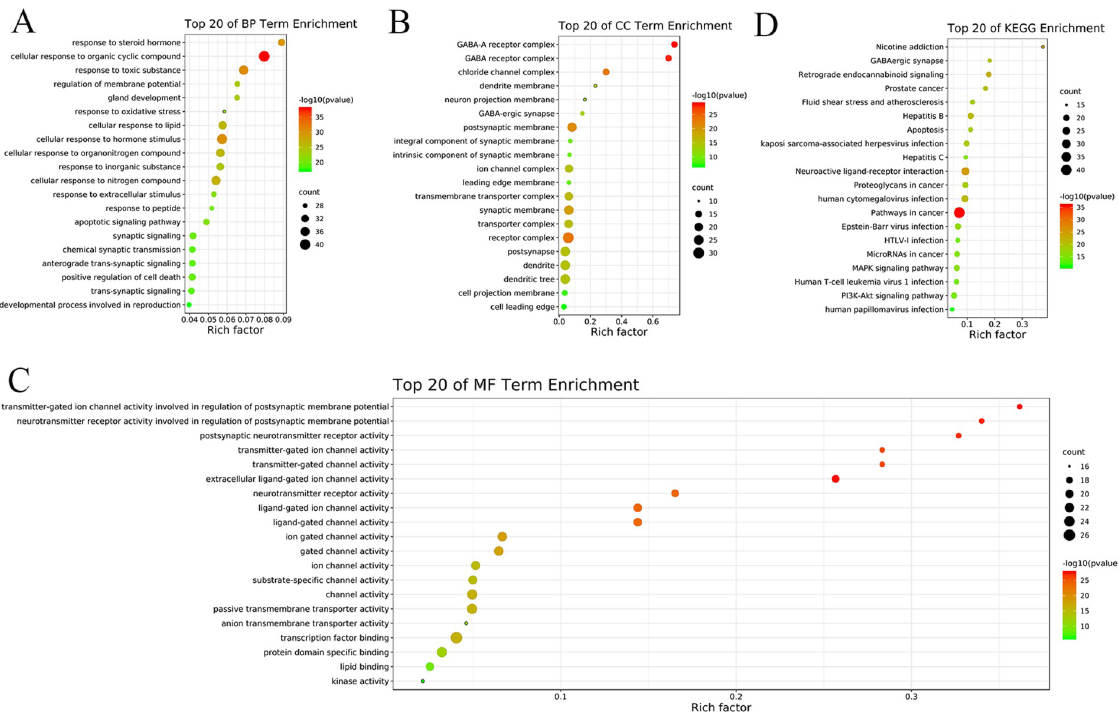
Fig 6. GO and KEGG analysis of targets. (A) GO biological process terms. (B) GO cellular component terms. (C) GO molecular function terms. (D) KEGG pathway. The size of each dot corresponds to the number of genes annotated in the entry, and the color of each dot corresponds to the corrected p-value.